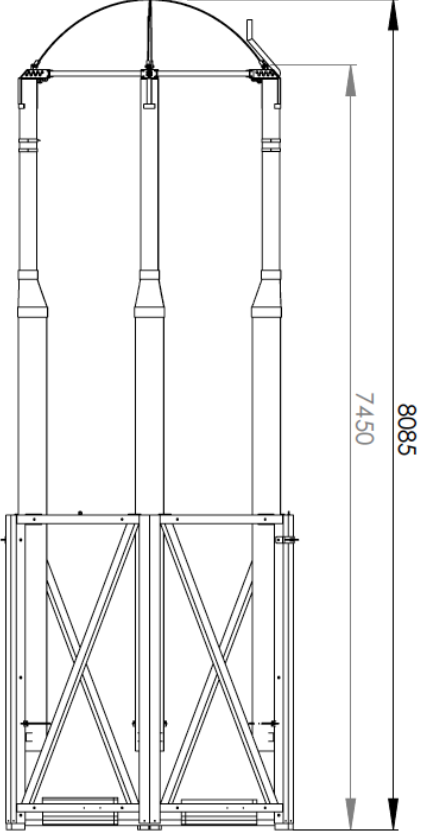
Fig. 1. Drawing of floatation frame with steel structure (lower part), glass fibre tubes for buoyancy, and steel ring at top, holding the dome-shaped PVC hoods. The tapering of the tubes in the above- surface section reduces buoyancy changes due to wave activity. Size indications in